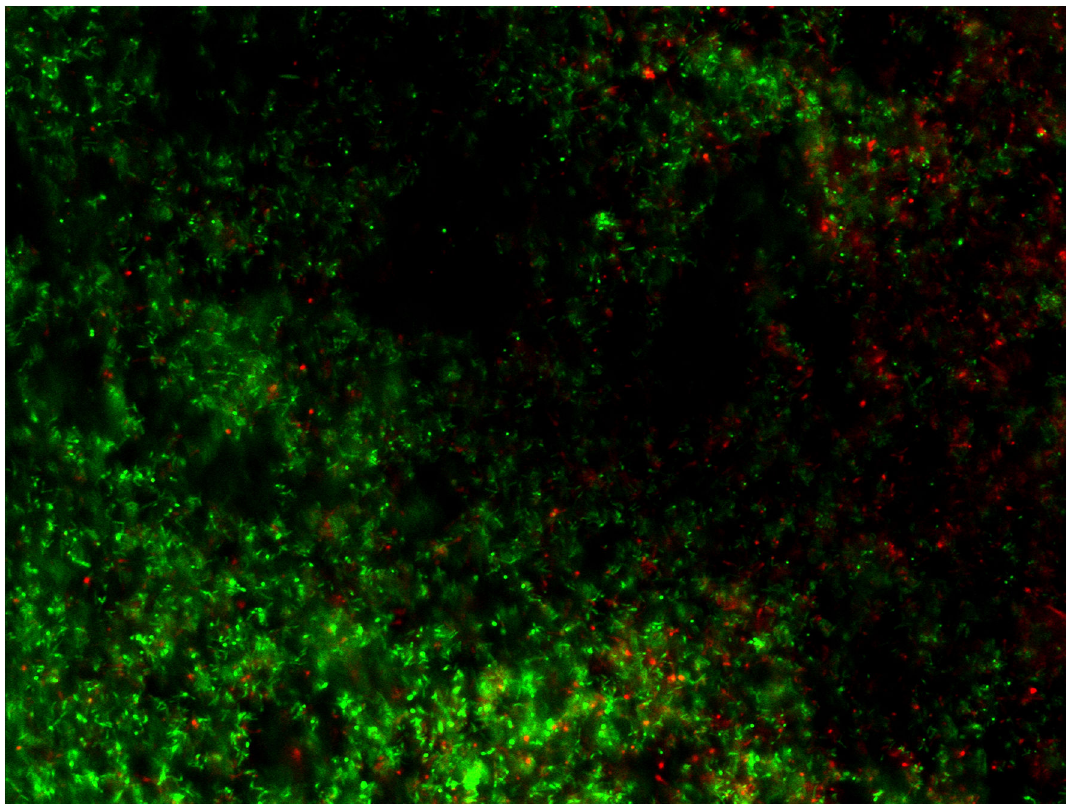
Figure 3. Superimposed fluorescence microscopic image (magnification 400 fold) of vital (green) and non-vital (red) colonization with A. viscosus on material ST after